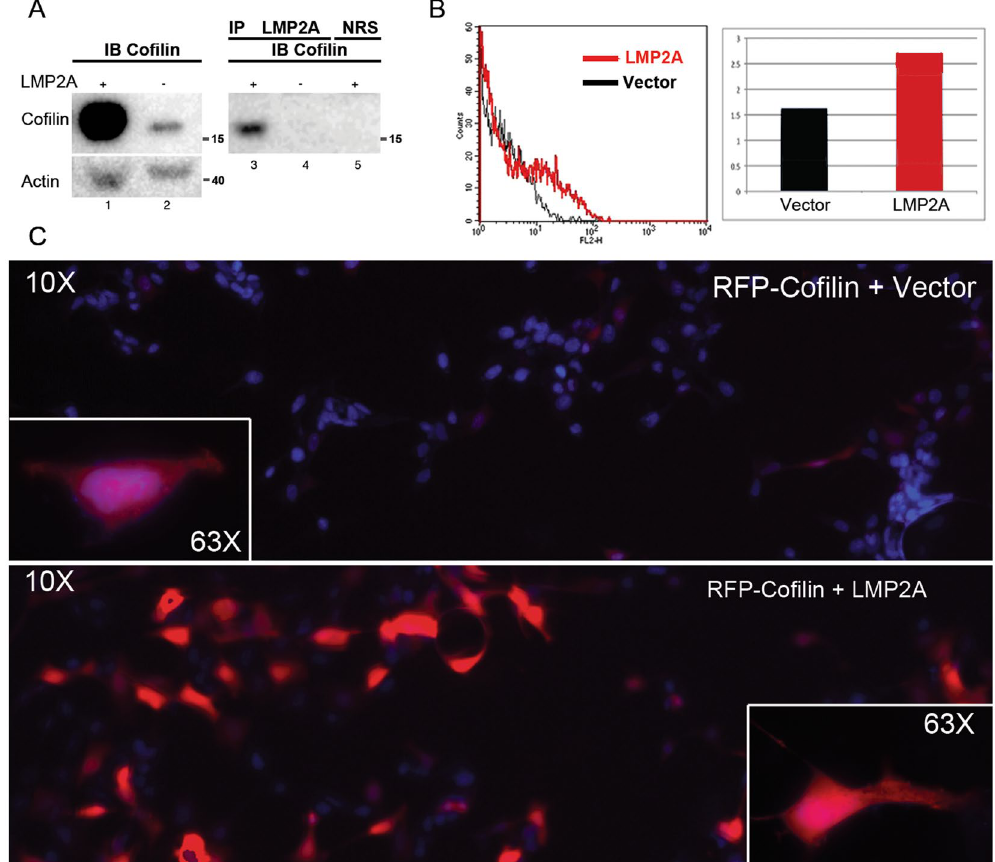
Figure 1. LMP2A binds cofilin and influences its stability. ( A ) WB analysis of cofilin levels in wcl of the NPC cell line CNE2 (lanes 1 and 2), lanes 3 and 4 show IP LMP2A, lane 5 shows IP NRS, lanes 3–5 probed with cofilin antibody. Full-length blot is presented in Supplementary Figure S5. ( B ) FACS analysis of cofilin expression in HEK293 epithelial cells. Histogram plot in the left panel shows red fluorescence intensity (FL2-H) on the horizontal axis and cell count on the vertical axis. Cells were transiently transfected with RFP-cofilin in combination with either an empty vector plasmid (black) or a LMP2A coding plasmid (red). Right panel: Staple diagram showing the geometric mean values of fluorescence intensities of RFP-cofilin in the FACS analysis shown in the left panel. ( C ) Microscopic analysis of HEK293 epithelial cells transiently transfected either with RFP-cofilin alone (upper panel) or together with LMP2A (lower panel), at 10x magnification. Insertions show single cells from the corresponding cultures at 63x magnification. Equal input of RFP-cofilin was used in both